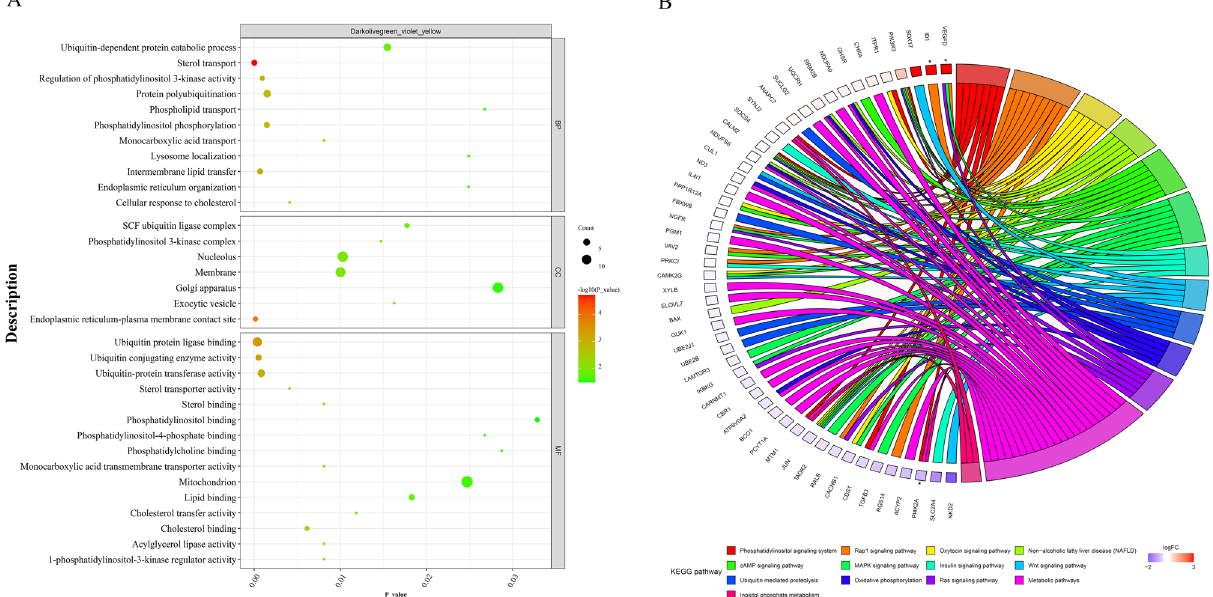
Figure 4. Enrichment analysis of hub genes. ( A ) Bubble plot of GO enrichment analysis of hub genes; ( B ) Circos plot of KEGG enrichment analysis of hub genes, with *for